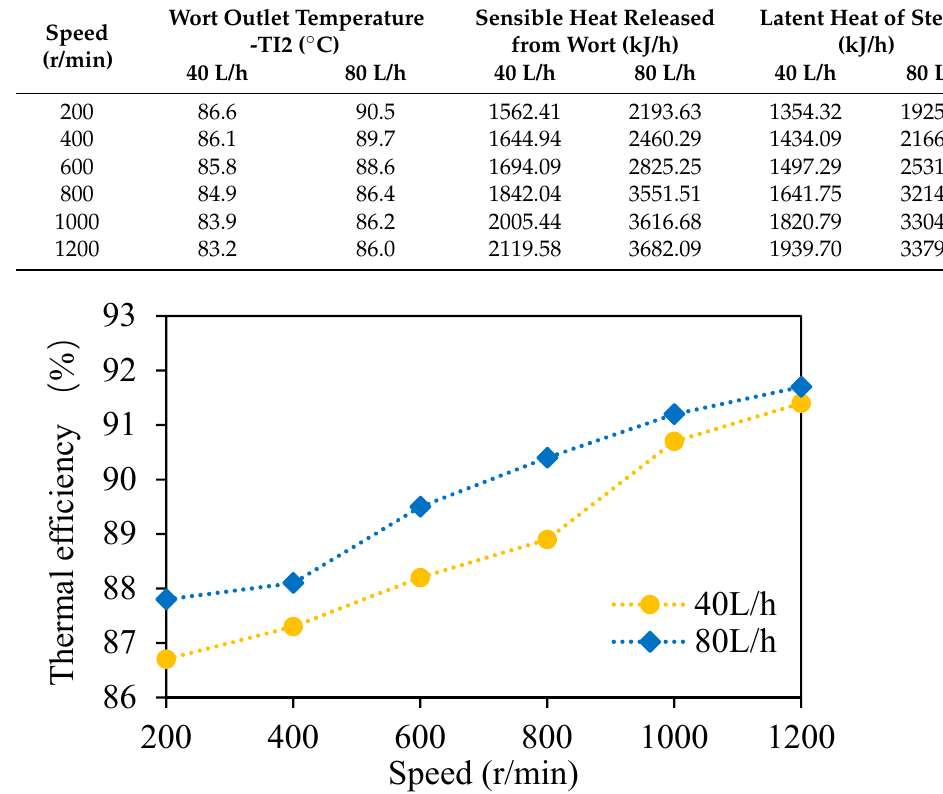
Figure 8. Thermal efficiency of wort self ‐ evaporation.